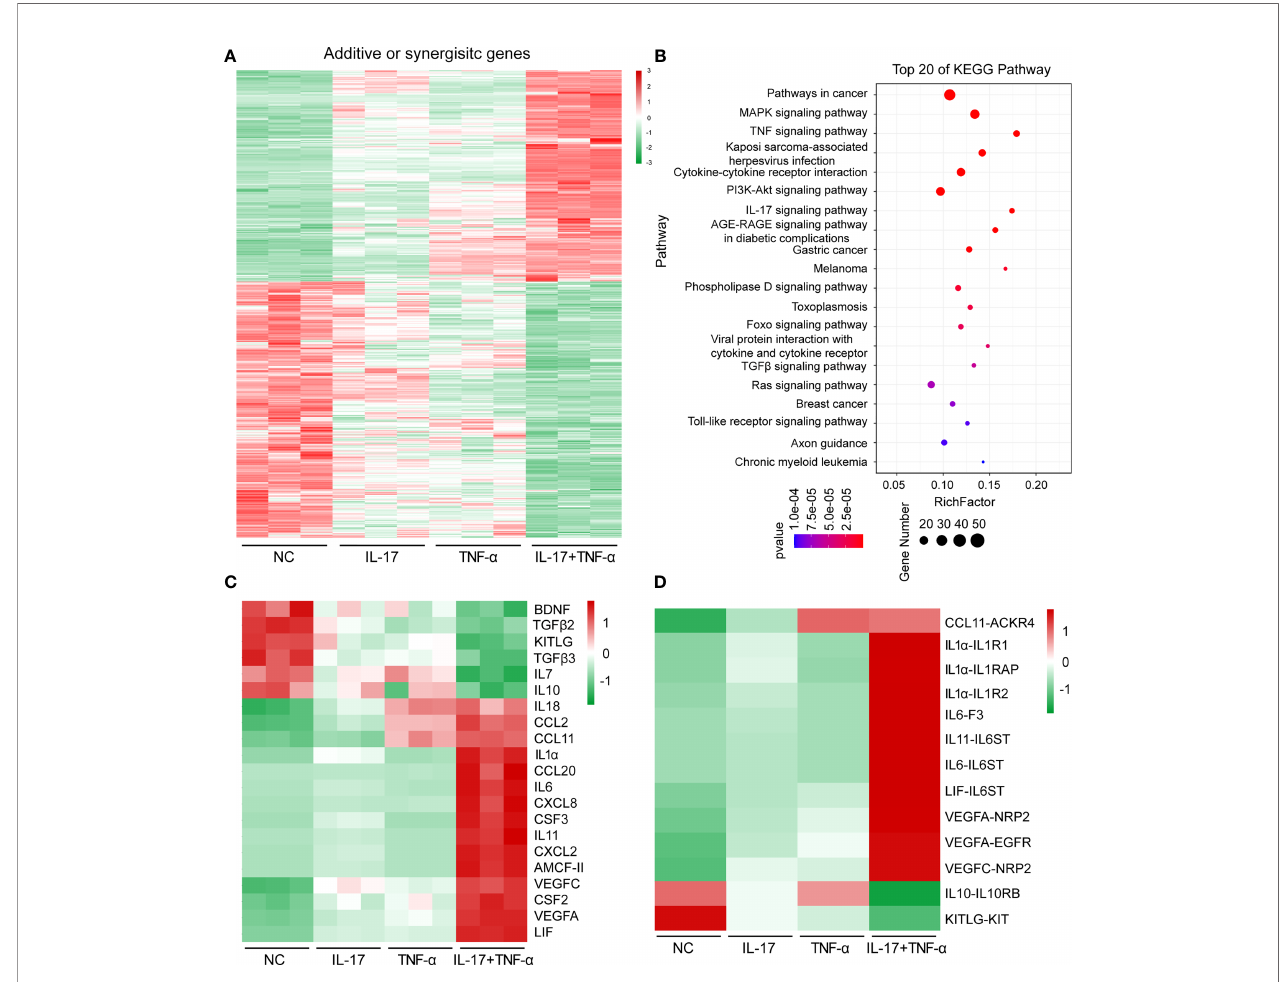
FIGURE 1 | Human IL-17 and TNF- a additively or synergistically induced the expression of hundreds of genes in porcine aortic endothelial cells. (A) Heat map of additive or synergistic genes (ASGs) in the control group, IL-17 group, TNF- a group, and IL-17 plus TNF- a group. (B) Top 20 enriched Kyoto Encyclopedia for Genes and Genome pathways of ASGs between the control group and the IL-17 plus TNF- a group. (C) Heat map of regulated cytokine or chemokine gene expression levels in the control group, IL-17 group, TNF- a group, and IL-17 plus TNF- a group. (D) Ligand and receptor analysis of ASGs in the control group, IL-17 group, TNF- a group, and IL-17 plus TNF- a